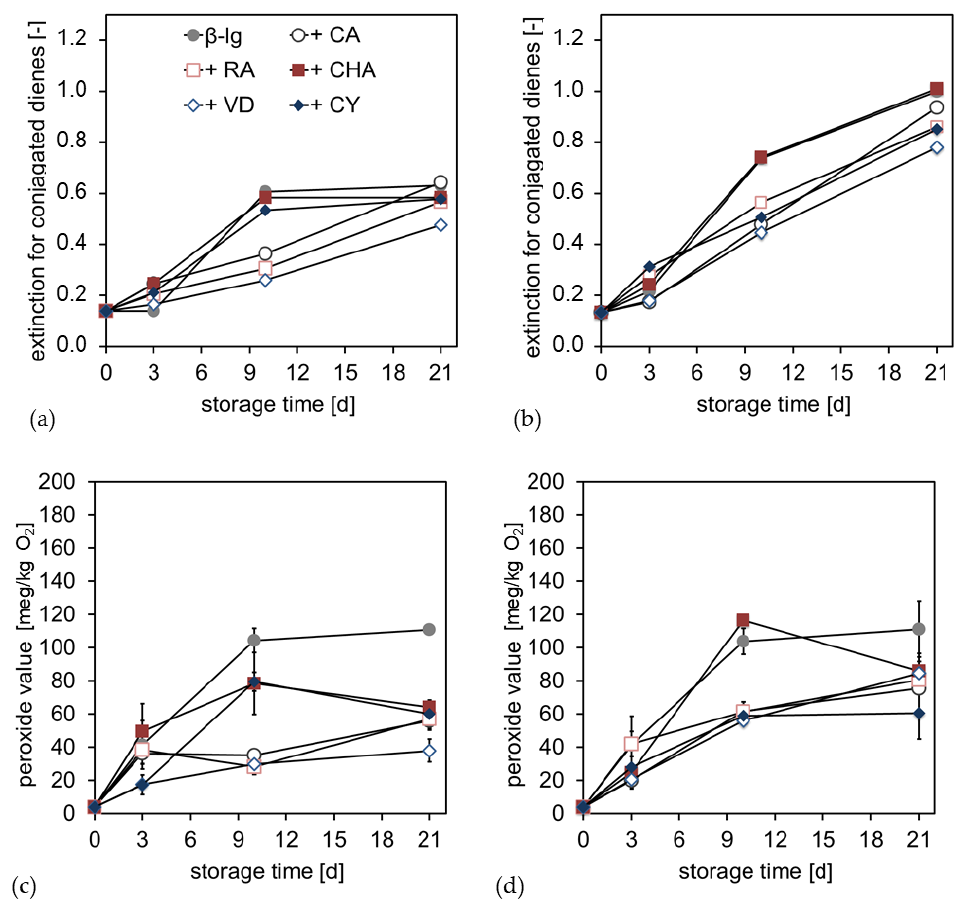
Figure 6. Extinction of the emulsion oil extract at 233 nm as an indicator for the formation of conjugated dienes within the emulsion ( a ) at pH 6 and ( b ) at pH 9; peroxide values for emulsions stabilized by different PCD and stored for 21 days ( c ) at pH 6 and ( d ) at pH 9. With the formation of CD, an increase in the peroxide value (POV) could also be es- timated for pH 6 and 9. Considered over the storage time, the POVs were highest for the pure β -Lg emulsion. At pH 6, CHA and CY again showed a faster increase in POV than CA, RA, and VD. However, over the storage time, POV decreased again, so that at the end of the storage time, POV for emulsions with PCDs were between 40 and 60 meq/kg O 2 , while the emulsion without PCDs was approximately 110 meq/kg of O 2 . At pH 9, there was a significant increase in the POV of the emulsion with CHA, at about 120 meq/kg of